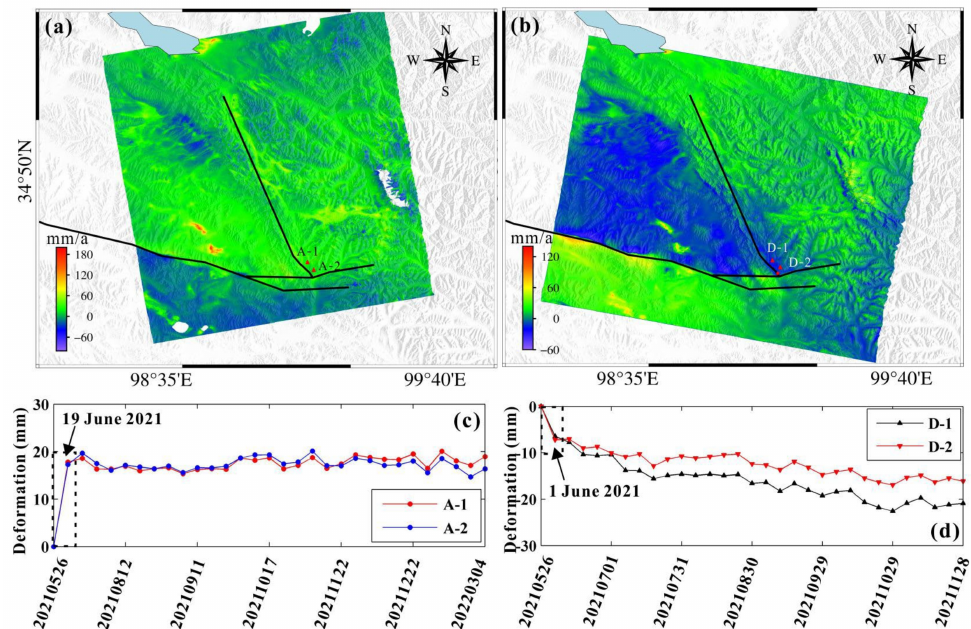
Figure 11. Post-seismic InSAR deformation of the 2021 Maduo earthquake in the seismic zone. Post-seismic surface deformation velocity of the ascending ( a ) and descending ( b ) orbital tracks of the Sentinle-1 satellite. The red triangles indicate the selected point, and the time-series InSAR deformations of them are shown in ( c , d ). The red circle in Figure 11b denotes the location of the field investigation of the Changmahe fault (Figure